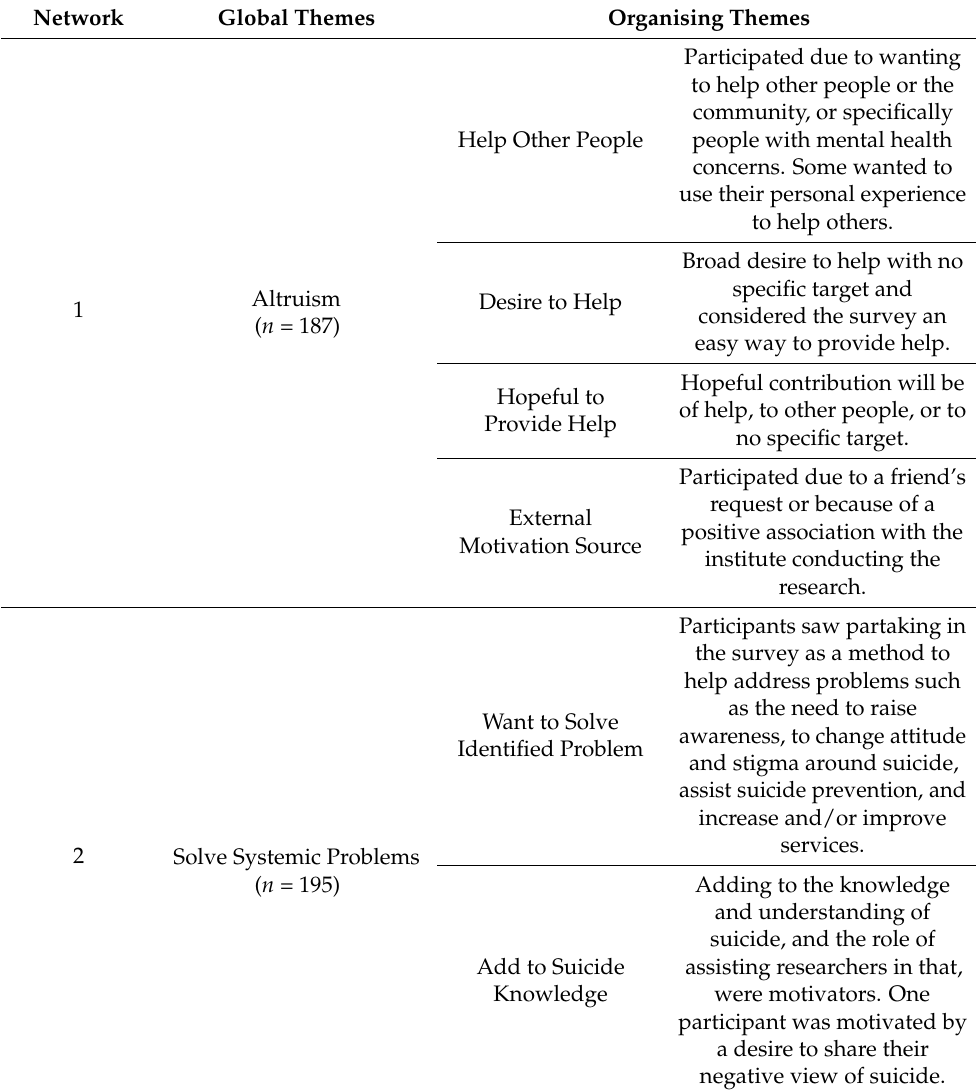
Table 2. Thematic Network Analysis and resultant thematic